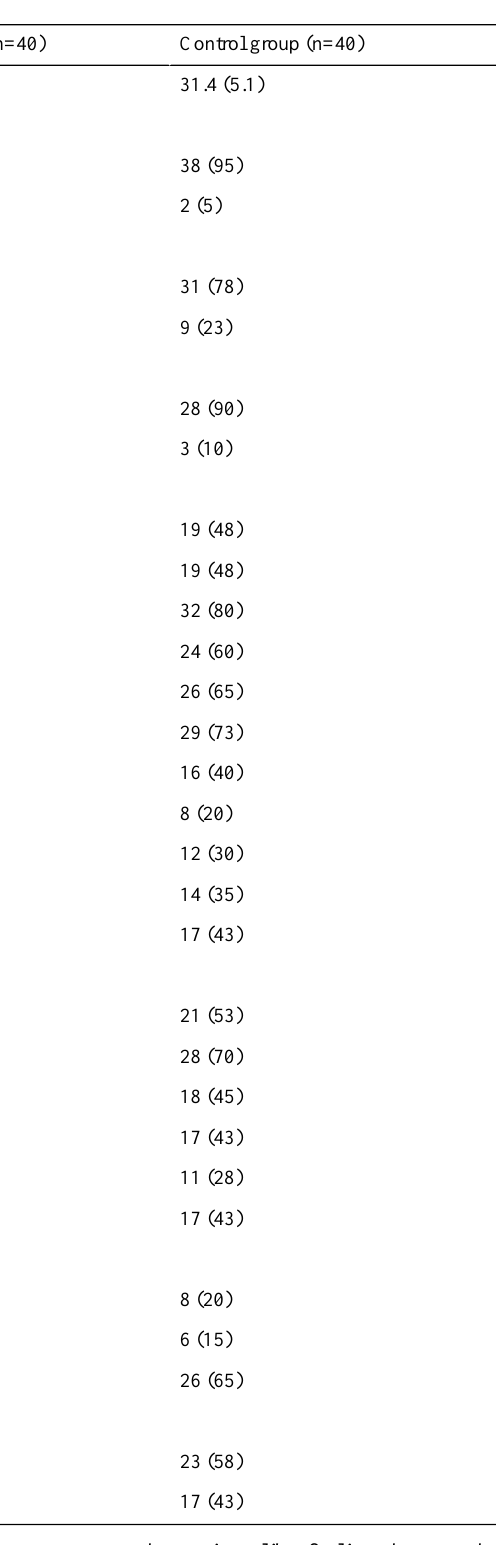
Control group (n=40)Intervention group